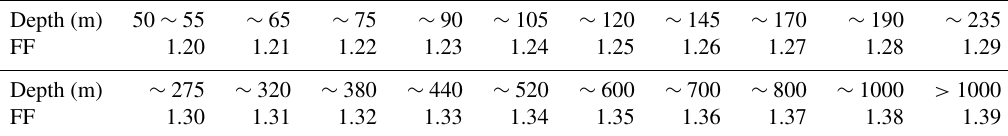
Table 2. Fixed factors (FFs) for vertical discretization for different lakes based on depth. Depth